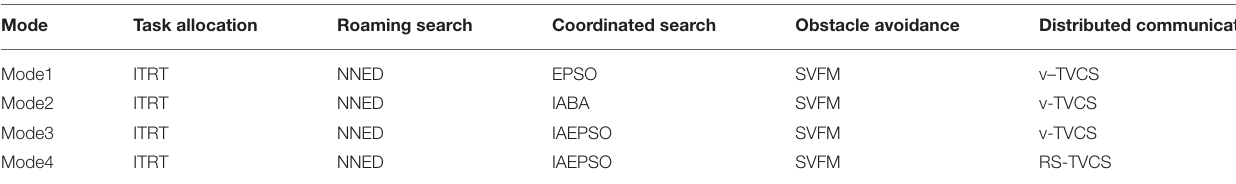
TABLE 3 | The four search algorithm mode